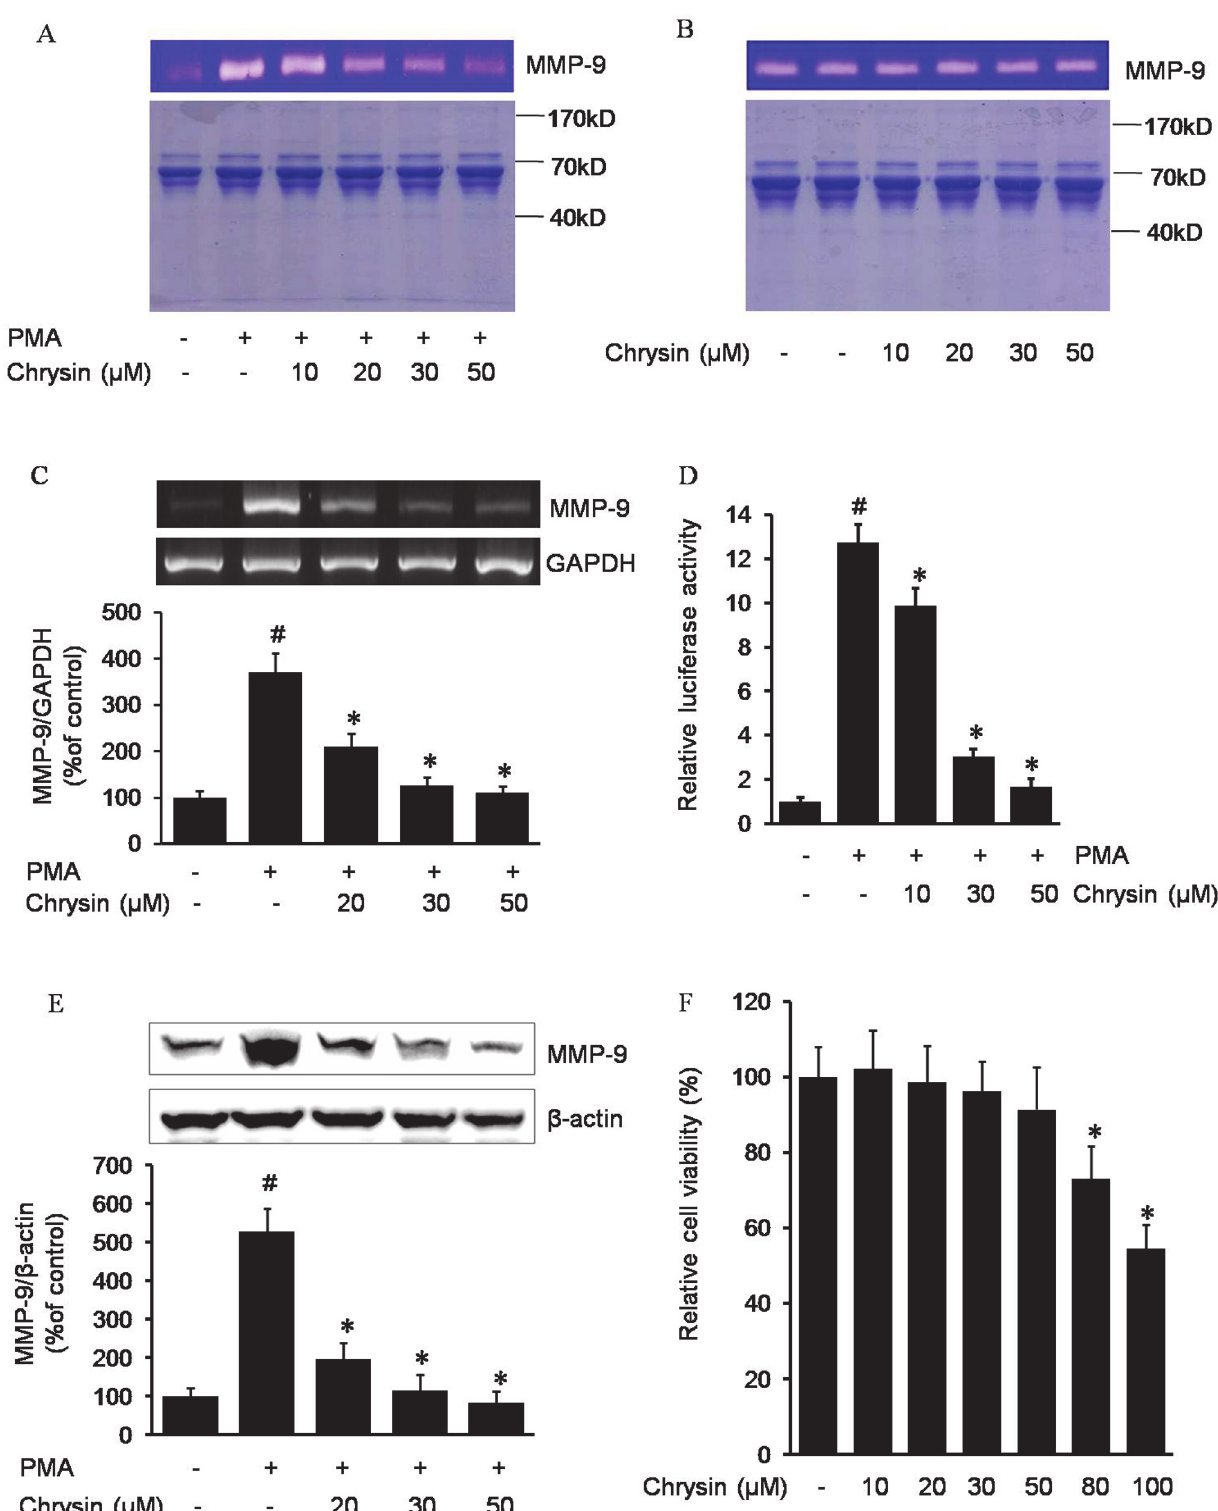
Fig 1. Chrysin inhibits PMA-induced MMP-9 in AGS cells. A total of 2×10 6 cells pretreated with the indicated concentrations of chrysin for 1 h were treated with 100 nM PMA for 20 h. After incubation, cell culture media supernatant was collected and gelatin zymography was performed to analyze the MMP-9